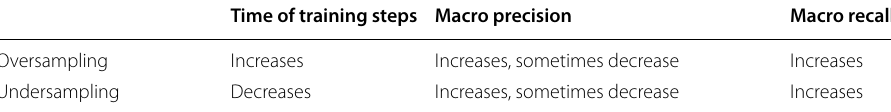
Table 46 Summary for oversampling and undersampling highly imbalanced datasets Time of training steps Macro precision